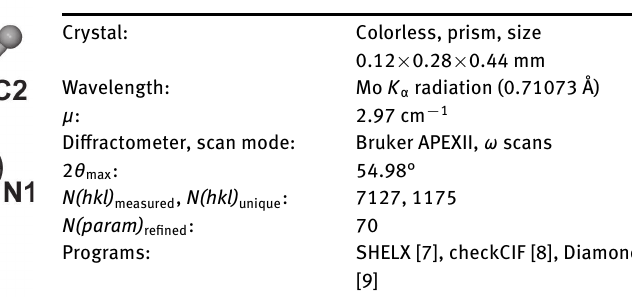
Table 1: Data collection and handling.